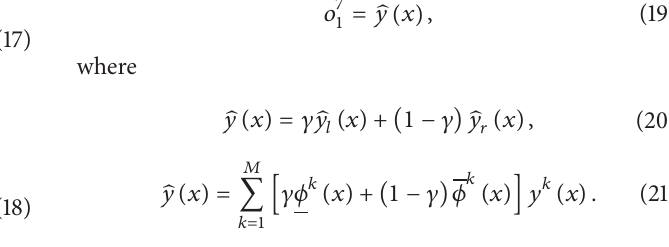
2.2. IT2FNN-2 Architecture. An IT2FNN-2 [31] is a six- layer IT2FNN, which integrates a first order TSKIT2FIS (interval type-2 fuzzy antecedents and interval type-1 fuzzy consequents), with an adaptive NN. The IT2FNN-2 (Figure 4) layers are described in a similar way to the